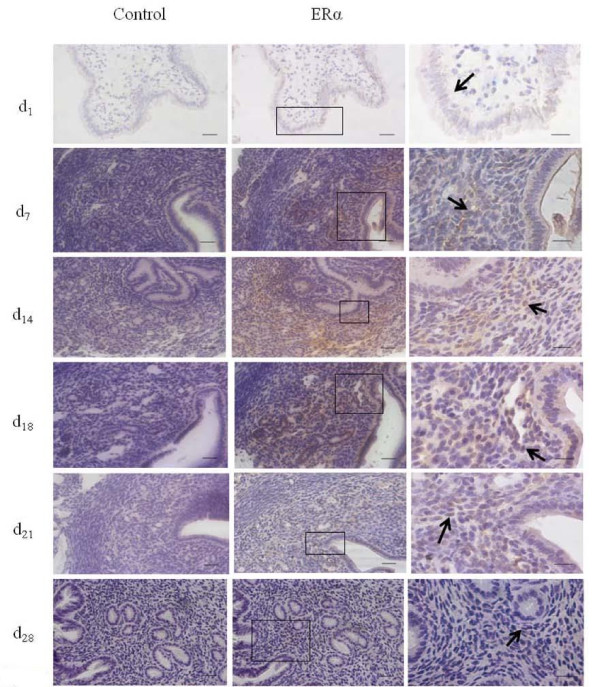
Immunohistochemistry analyses of ESR1 expression in postpartum mouse uterus. Left side was negative control, the middle and right showed ESR1 expression, which shown at middle (40×) and higher magnification (100×). Scale bar was 20 μm, while right side scale bar was 10 μm. The arrows indicate ESR1 immunopositive cells.